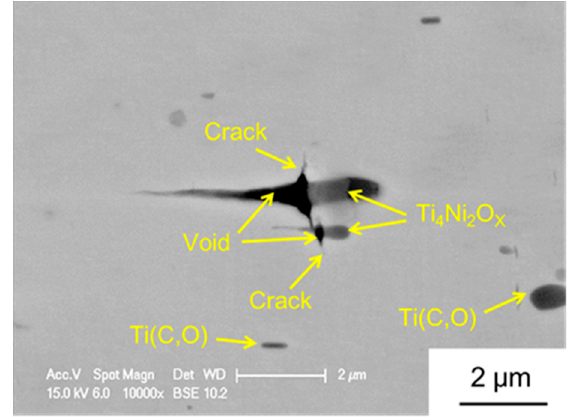
Figure 9. SEM-BSE image of C200O400 wire surface without failure after 10 7 cycles in the fatigue tests.